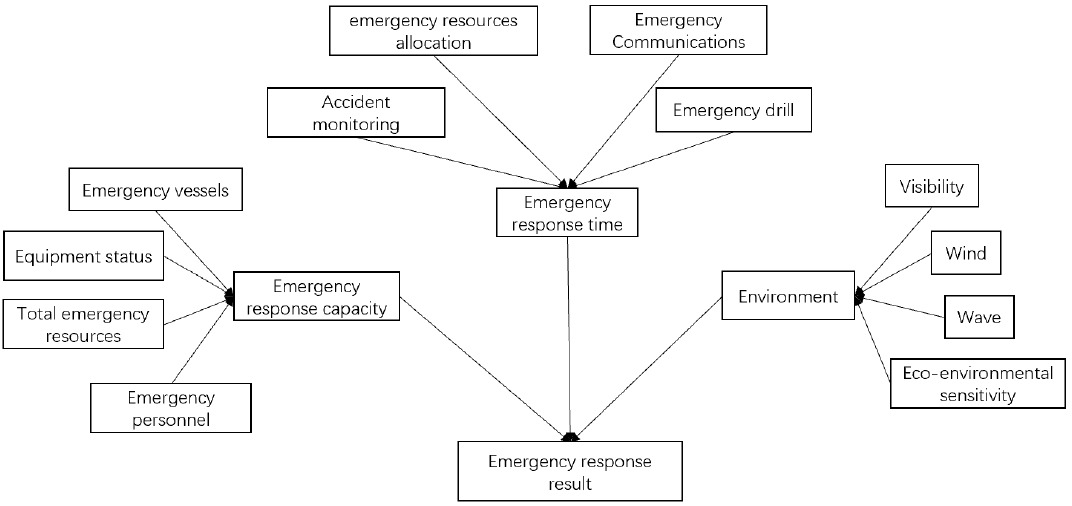
Figure 1. Bayesian network model for ship pollution emergency response.